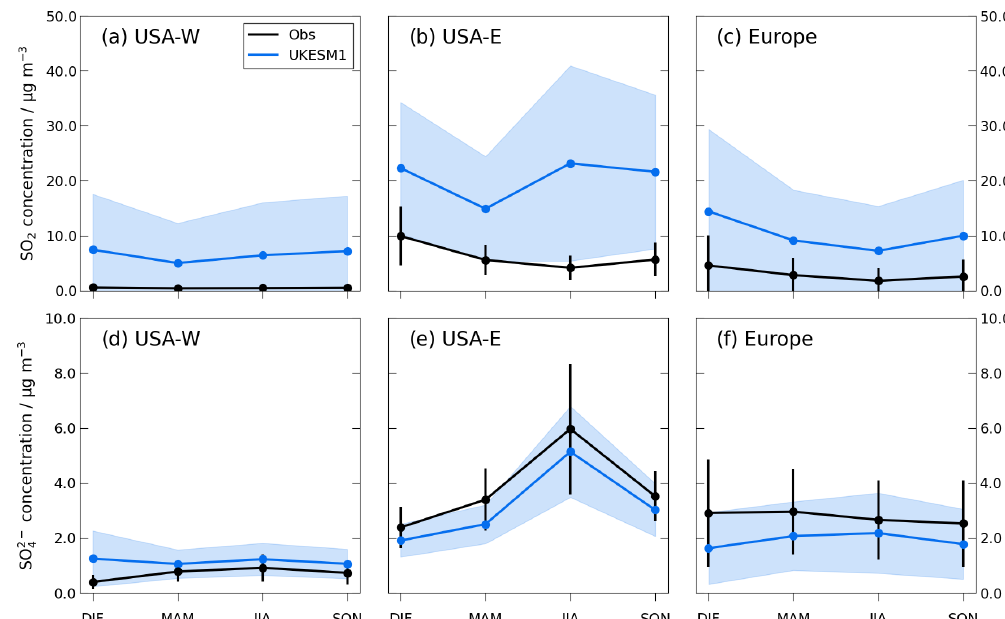
− concentration (d–f) for the period 4 ) = 42). The 4